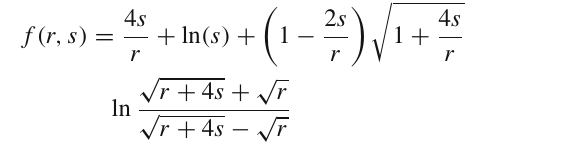
Fig. 1 Indirect constraints from μ ATLAS γγ = 1 . 06 ± 0 . 12, EWPT (taken from Ref. [39]) and perturbativity in the plane of m (cid:2) ±±± and (cid:2) m . Pink and cyan regions excluded at 2 σ C.L., while the region between blue curves are allowed at 2 σ C.L.. The pink regions with boundaries depicted in solid and dashed curves correspond to λ 3 = 1 and 0.1, respectively